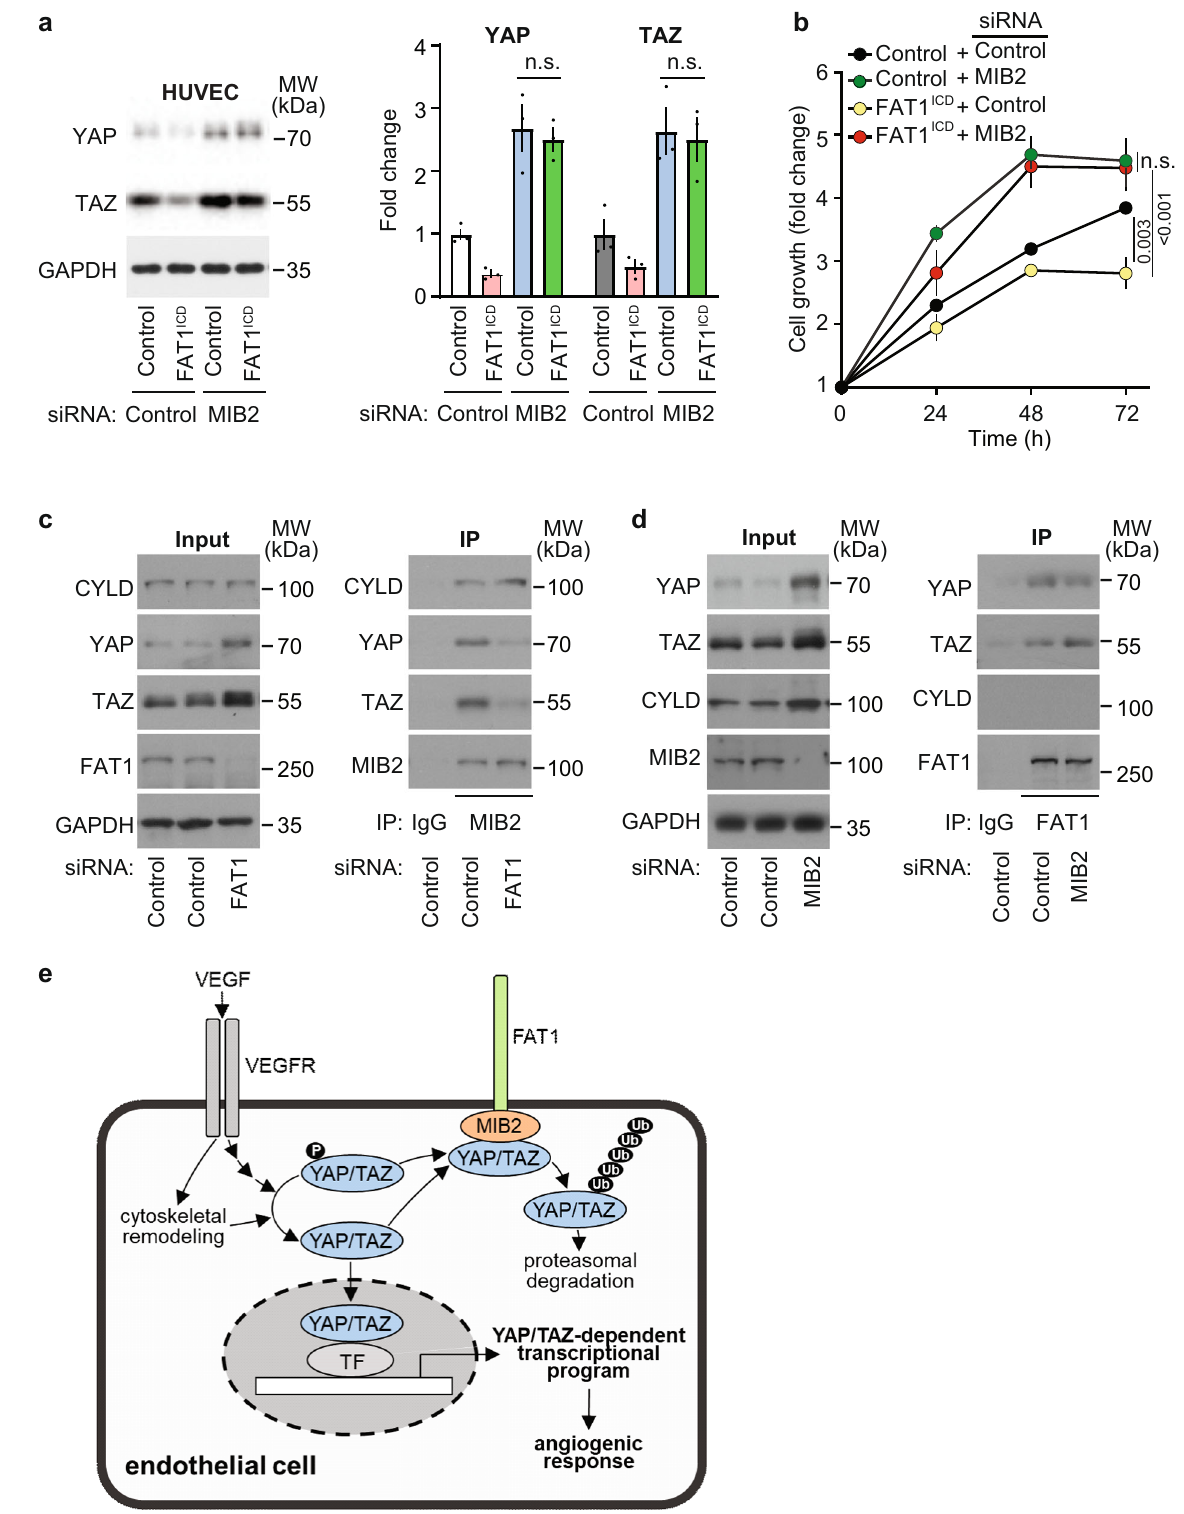
boiled for 10 min and were subjected to sodium dodecyl sulfate- polyacrylamide gel electrophoresis (SDS-PAGE). Protein was then transferred to nitrocellulose membranes, followed by overnight incu- bation with primary antibodies. Membranes were incubated with horseradish peroxidase-conjugated (HPC) conjugated secondary antibodies directed against rabbit or mouse IgG (Cell Signaling Tech- nology,catalog#7074and#7076,1:3000)for2